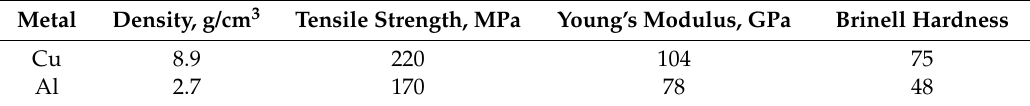
Table 2. Mechanical properties of metals used in the friction welding experiment.